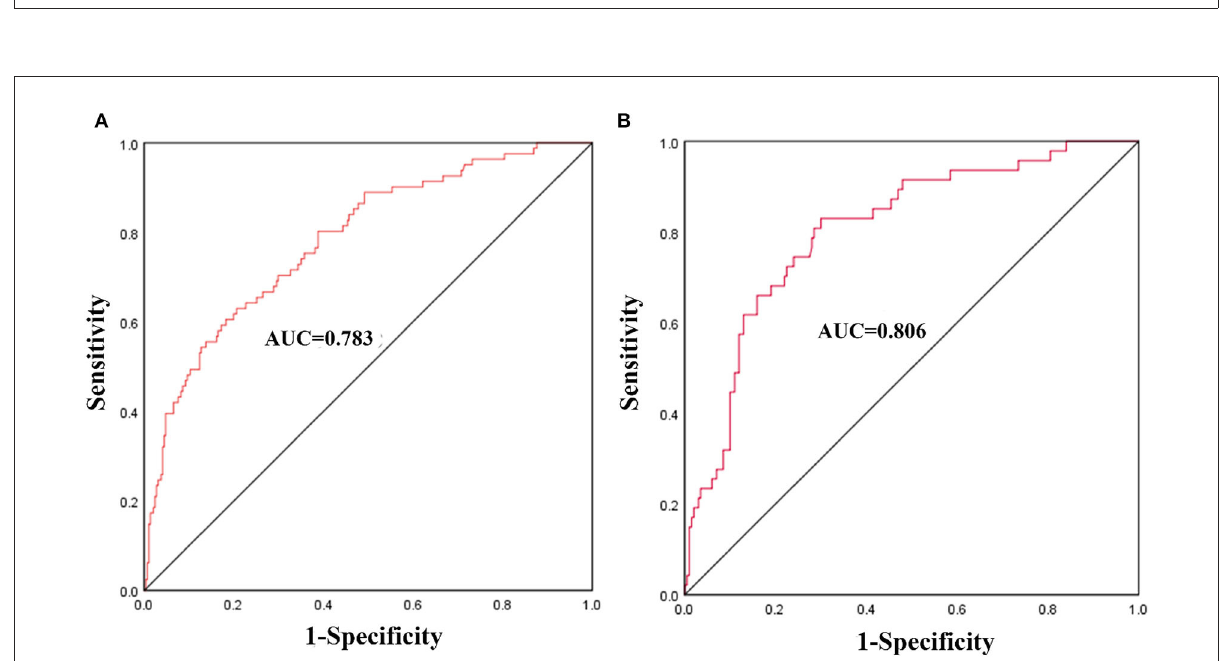
FIGURE3 The receiver operating characteristics (ROCs) curve of the nomogram model to predict malignant middle cerebral artery infarction in the derivation cohort (A) and validation cohort (B)